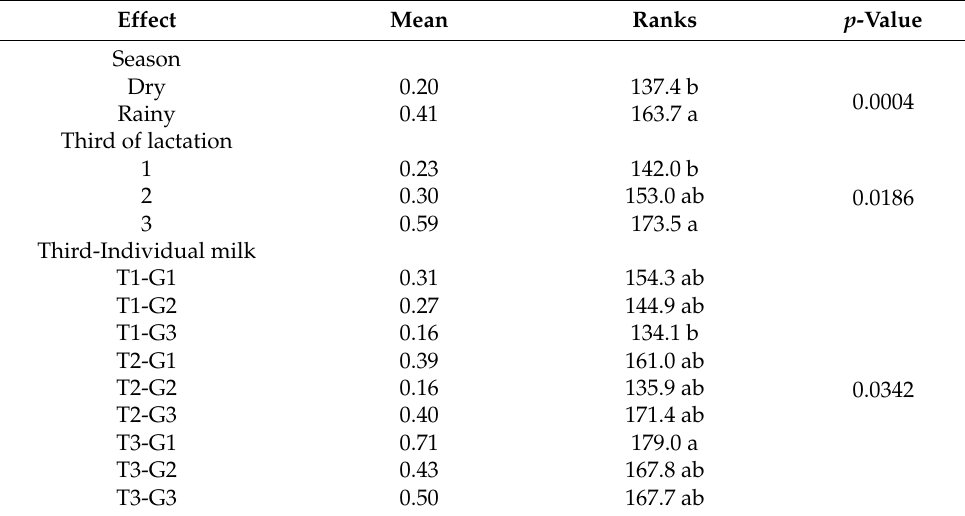
Table 5. Factors associated with CMT positivity (++ and +++) in the analyzed sample of dual- purpose cows. Effect Mean Ranks p -Value Season Dry